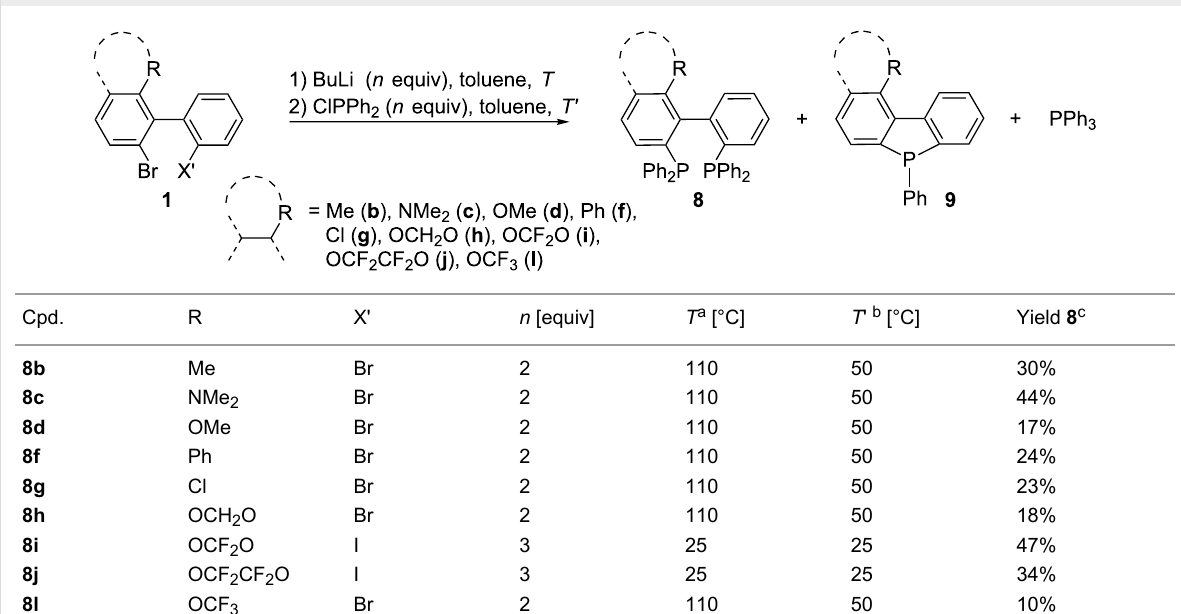
Table 2: Synthesis of bis(diphenylphosphino)biphenyls 8 .